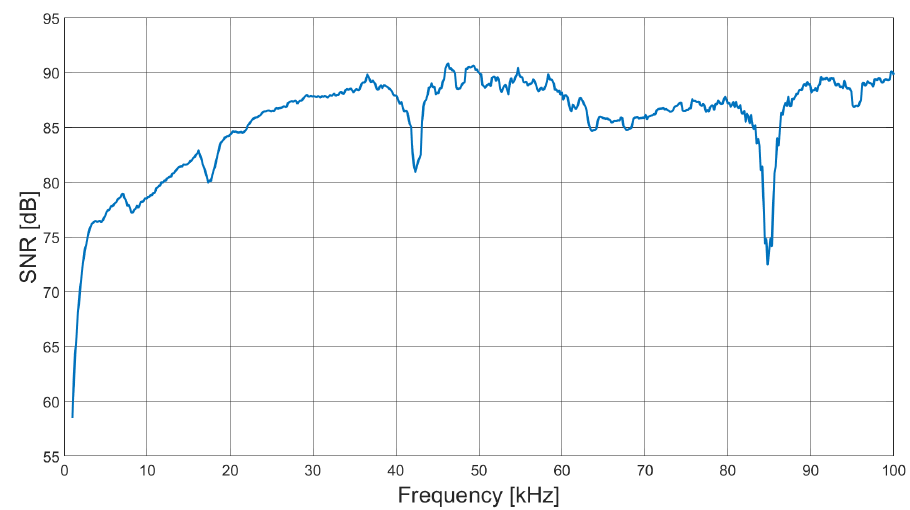
Figure 5. SNR as a function of excitation field